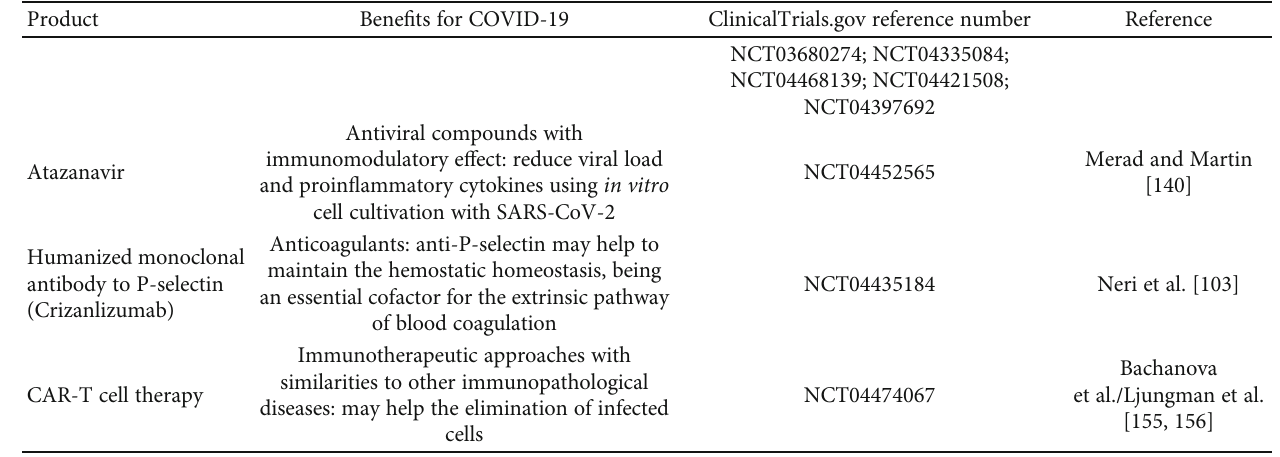
Table 2: Nonclinical studies focused on immunotherapy with potential bene fi ts to COVID-19 treatment. Product Potential bene fi ts for COVID-19